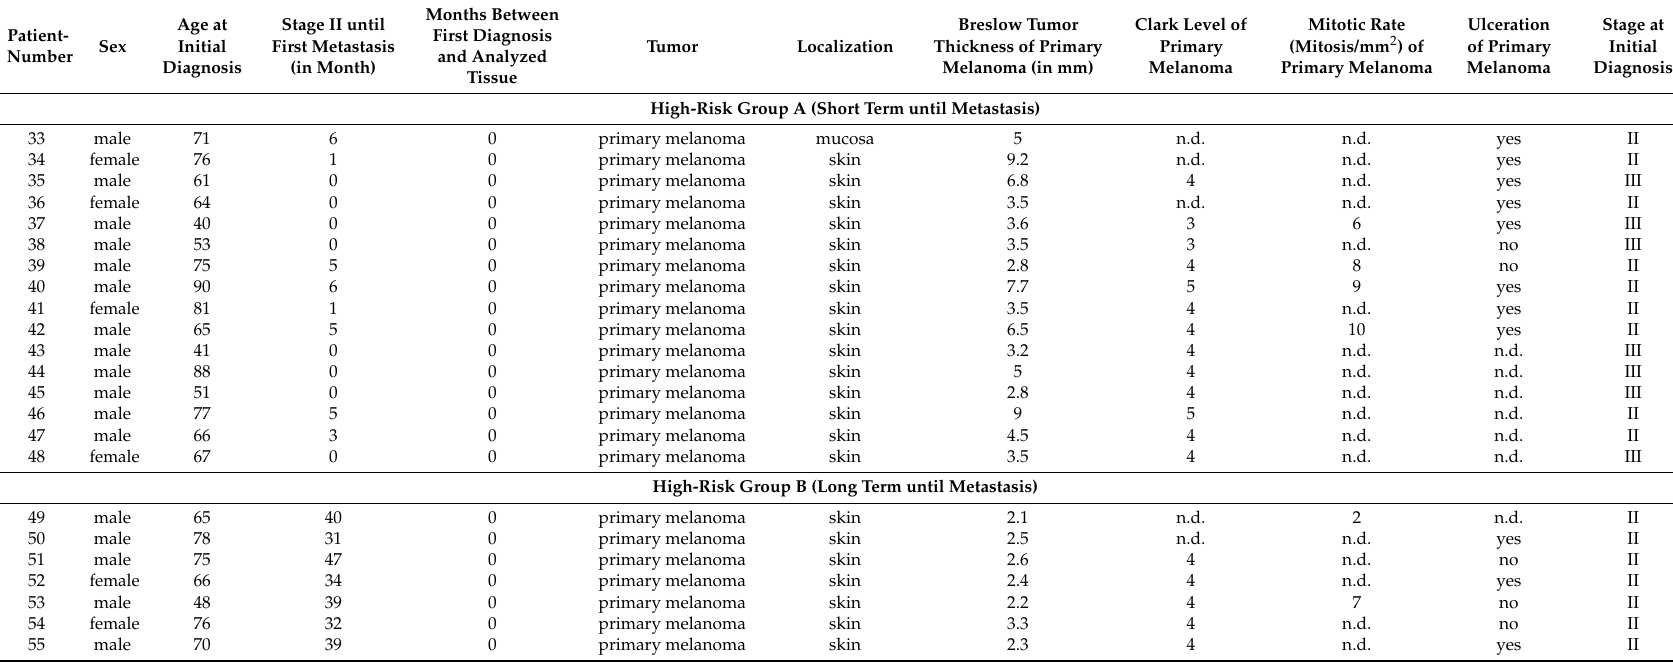
Table 7. Clinical data of patients with high-risk primary melanoma and short term until metastasis (high-risk group A) and long term until metastasis (high-risk group